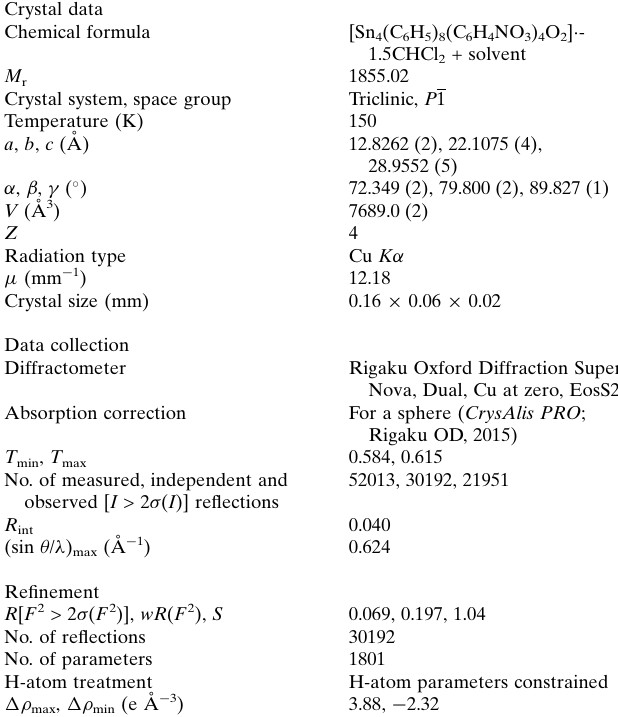
Table 2 Experimental details. Crystal data Chemical formula